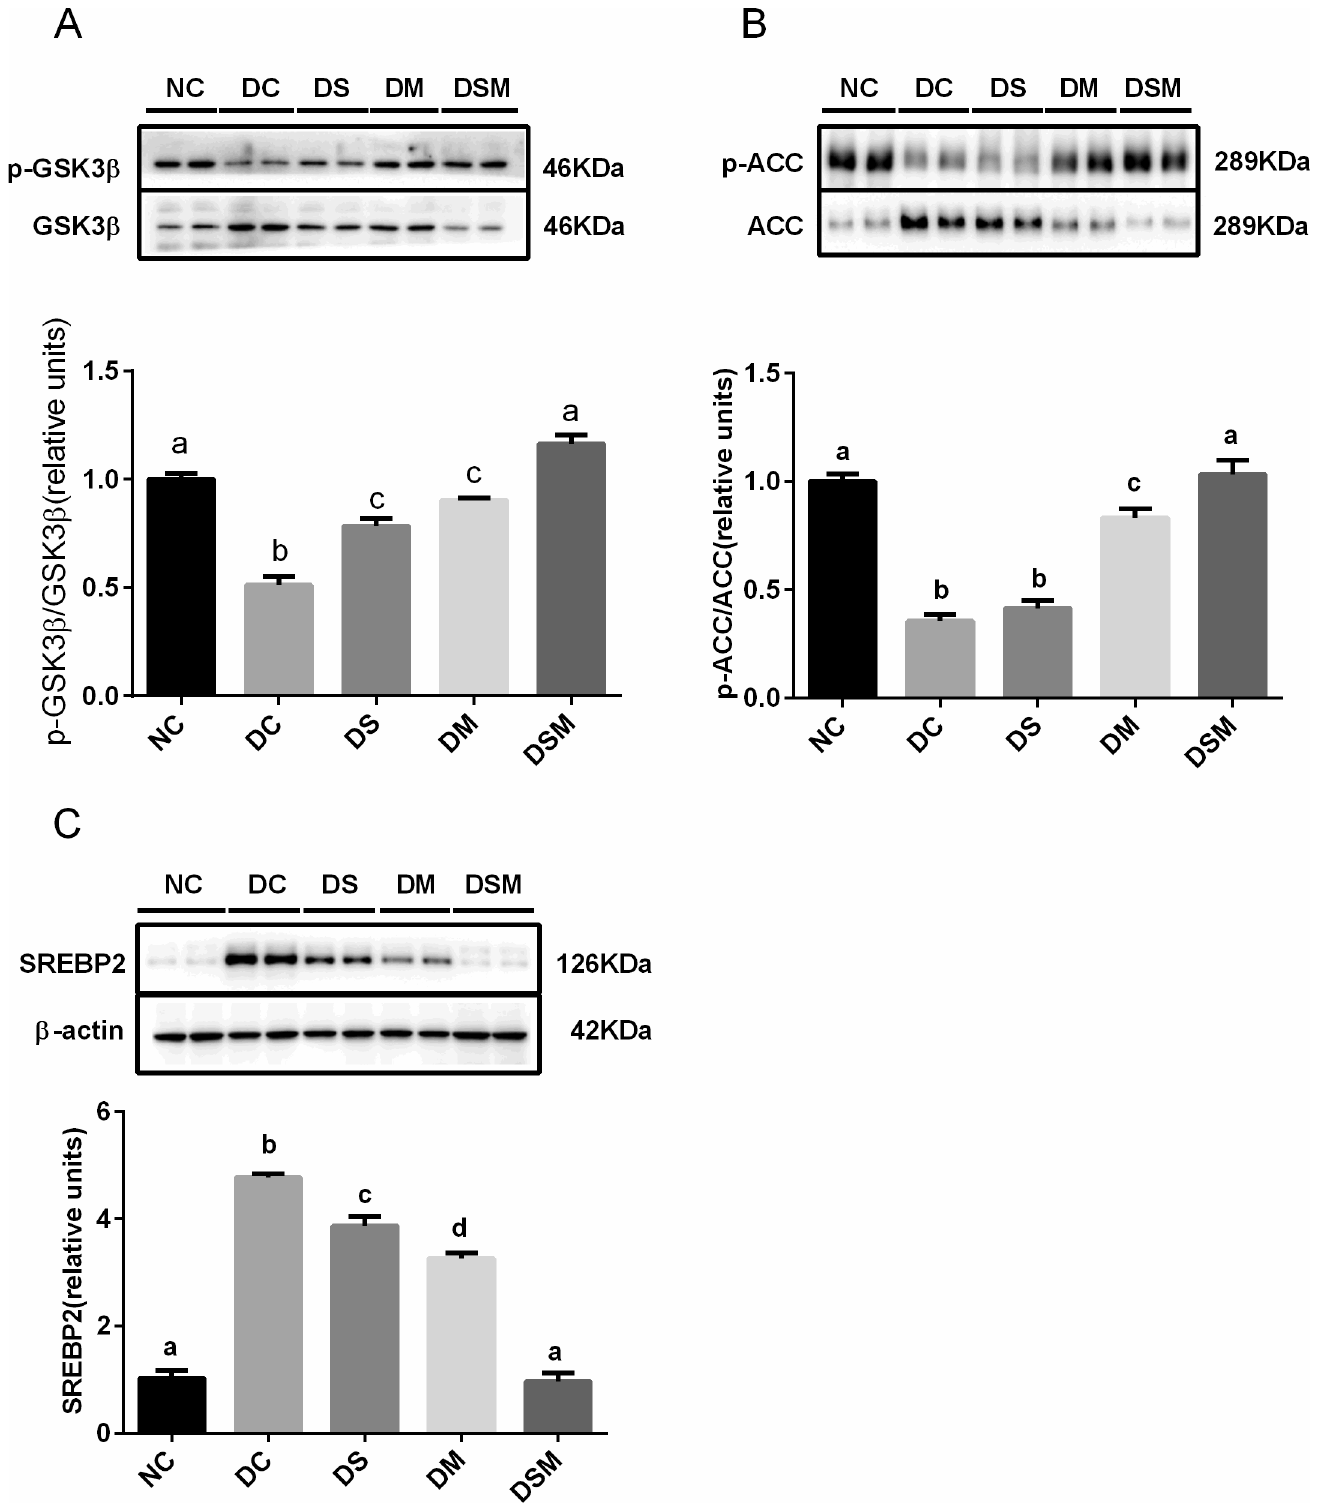
Fig 7. Combined intervention of swimming plus metformin boosts the energy storage and improves de novo lipogenesis in GDM skeletal muscle tissues. (A) Phosphorylation of GSK3 β was analyzed by immunoblotting and normalized to total GSK3 β proteins in skeletal muscle treated with swimming or metformin or both combined. (B) Levels of phosphorylated ACC in different groups were normalized to total ACC in the skeletal muscle treated with swimming or metformin or